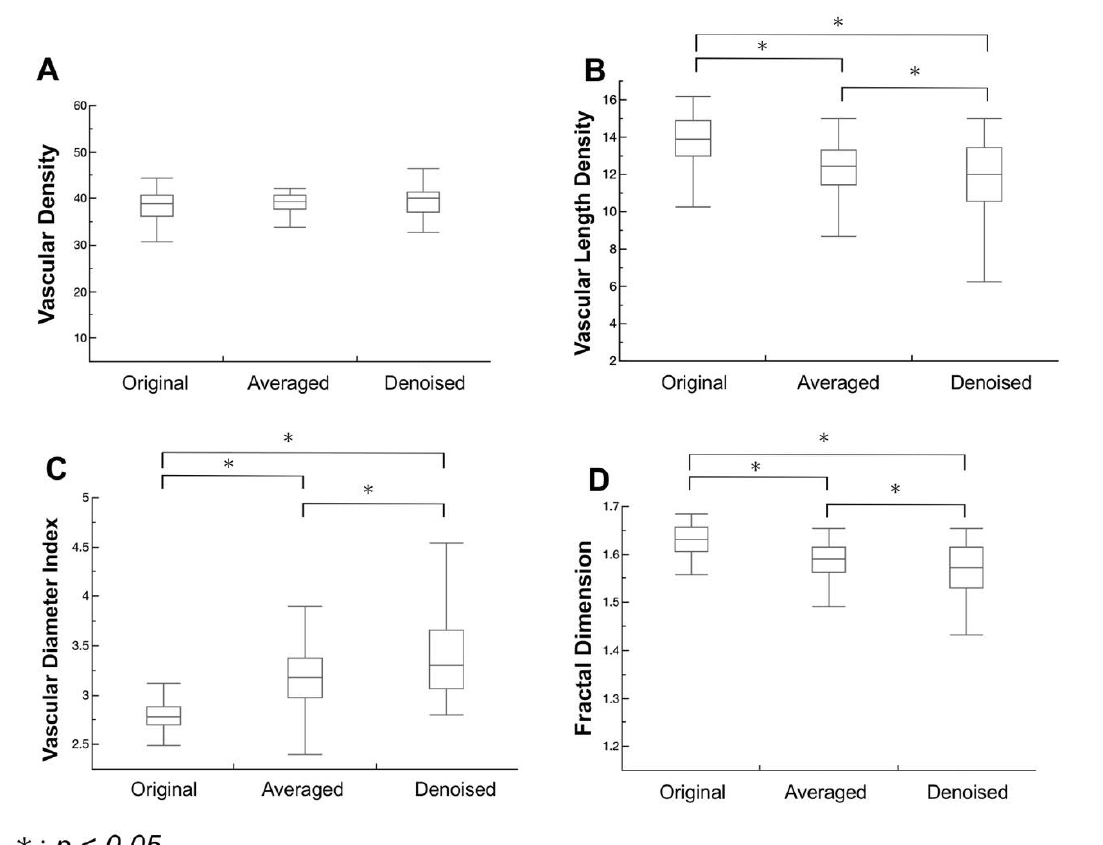
Figure 3. Quantitative analysis of microvascular density and morphology in optical coherence tomography angiography (OCTA) images. Box-whisker plots showing the values of ( A ) vascular density (VD), ( B ) vascular length density (VLD), ( C ) vascular diameter index (VDI), ( D ) and fractal dimension (FD). The horizontal lines represent the maximum (top line), third quartile (top of the box), median (line in the middle of the box), first quartile (bottom of the box), and minimum (bottom line). There are statistically significant differences in VLD, VDI, and FD among the original, averaged, and denoised images. Meanwhile, we found no significant difference in VD among the three images. We utilized P < 0.05 in the Tukey–Kramer test.